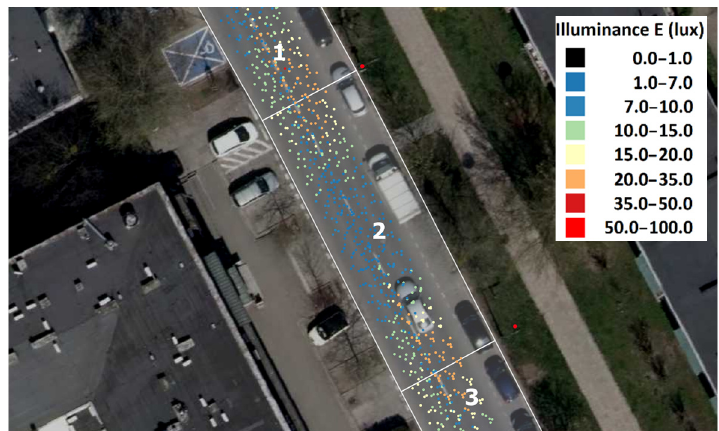
Figure A1. Example of five illuminance measurements in field No. 2.